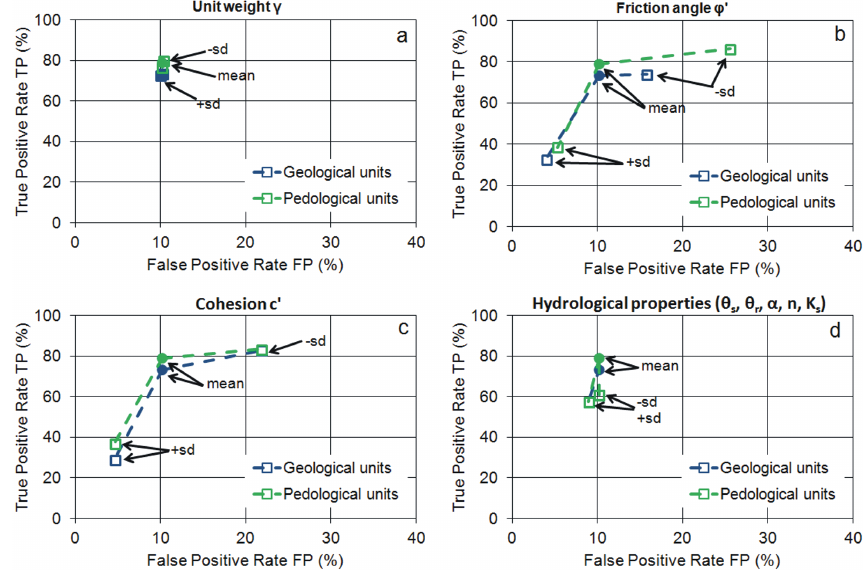
Figure 13. Shallow landslide susceptibility scenarios corresponding to the 27–28 April 2009 event for the study area by using TRIGRS- unsaturated model: (a) geological units and (b) pedological